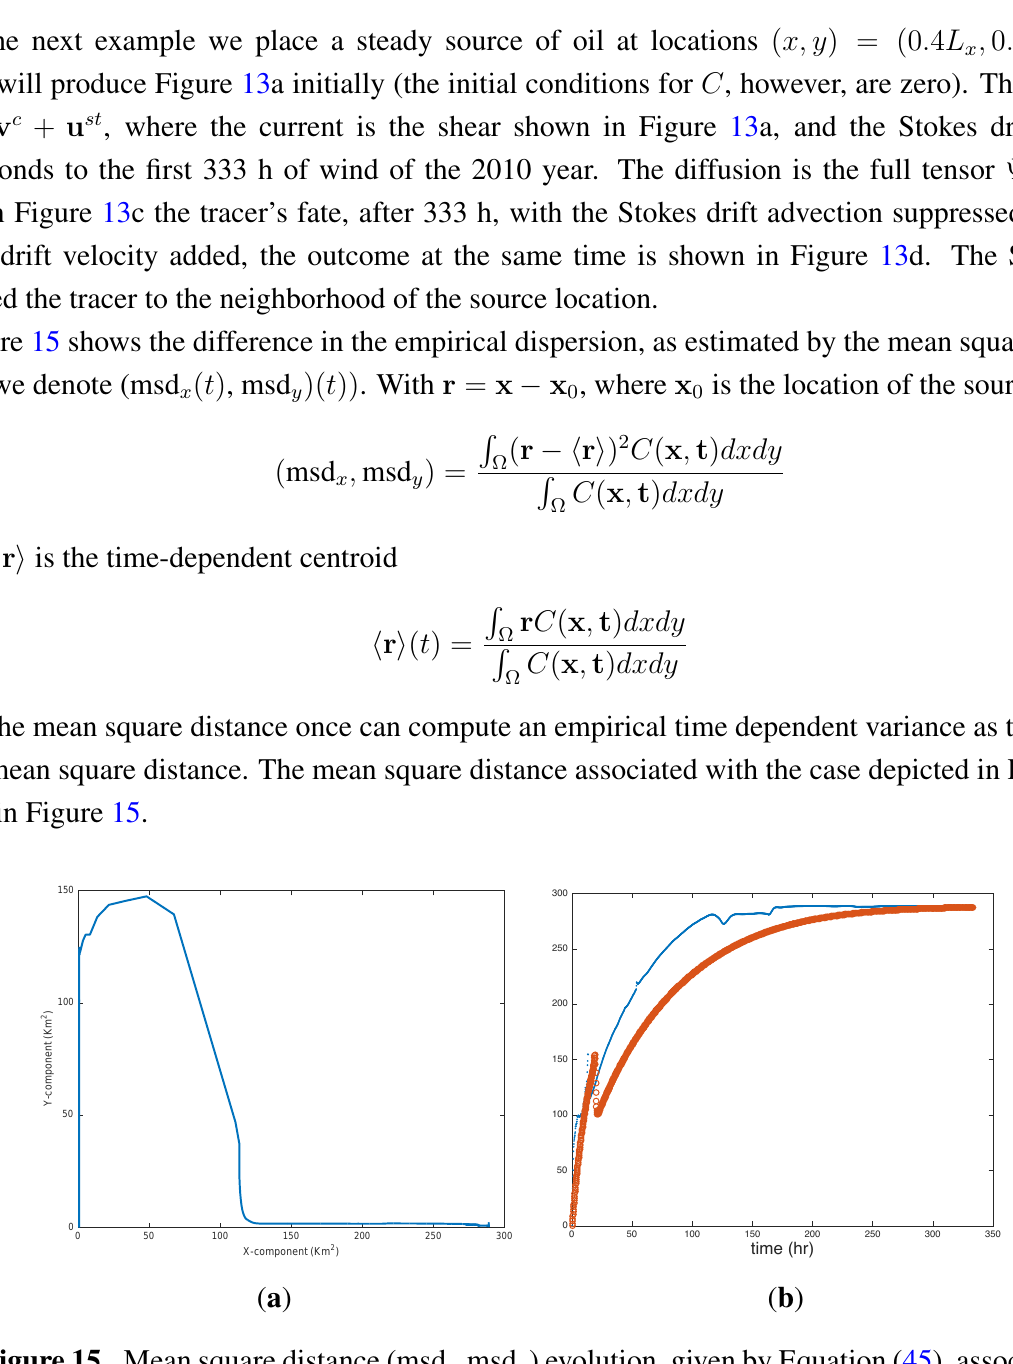
,msd ) evolution, given by Equation (45), associated x y